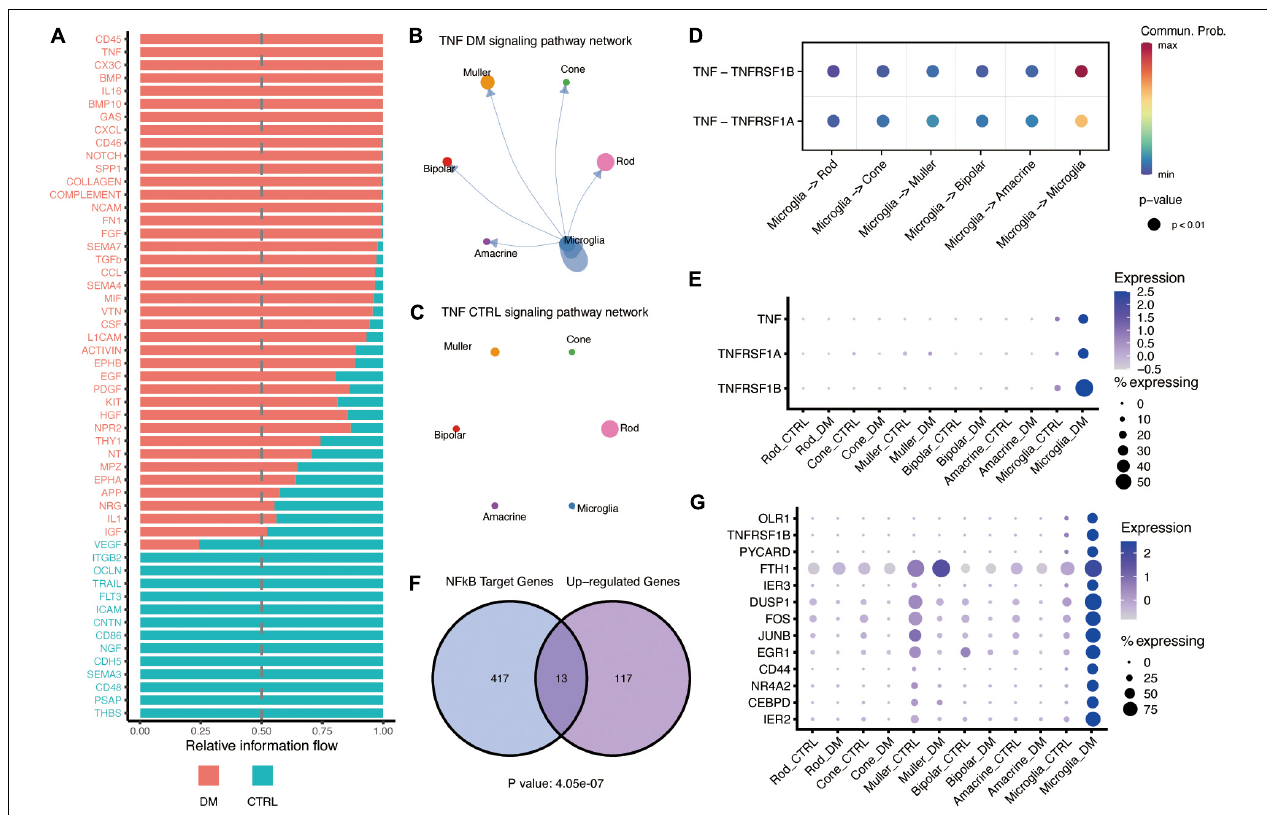
FIGURE 2 | TNF- α mediates interactions between activated microglia and other retinal cells under DM. (A) Barplot showing the all signaling pathways received by microglia, which were ranked based on their differences of overall information flow within the inferred networks. The top signaling (shown in red) are more enriched in diabetes, whereas the bottle ones (shown in green) are more enriched in control. (B,C) The inferred TNF signaling networks in the retina of DM (B) and control (C) monkey. Circle sizes are proportional to the number of cells in each cell type, width of the arrow lines represents the communication probability. (D) The significant ligand-receptor pairs of the TNF- α signaling pathway. The dot color and size represent the calculated communication probability and p -values, respectively. p -values are computed from the one-sided permutation test. (E) Dot plot showing the expression of ligand TNF- α and its receptors TNFR1 ( TNFRSF1A ) and TNFR2 ( TNFRSF1B ). (F) Venn diagram showing the significant enrichment of NF- κ B target genes in microglia activated by hyperglycemia. (G) Dotplot showing the expression of NF- κ B target genes enhanced by hyperglycemia in